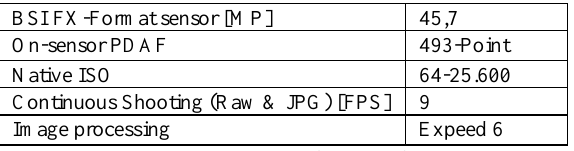
Table 1. Main technical specification of the Nikon Z7 Mirrorless digital camera.